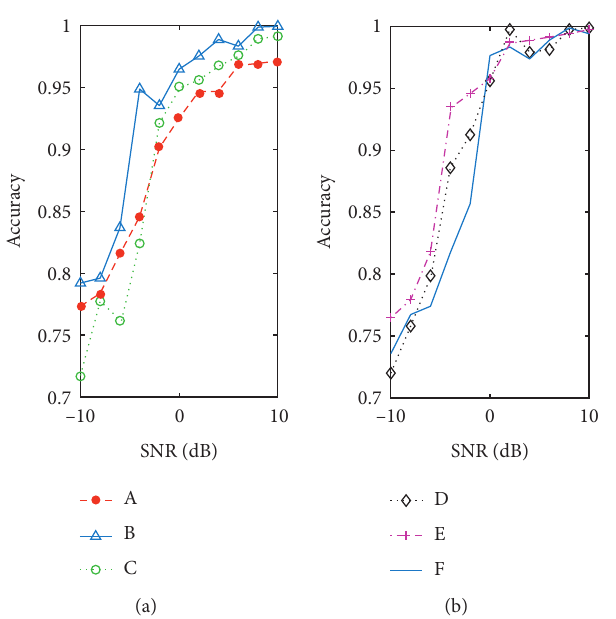
Figure 11: Different configured networks’ recognition accuracy: (a) different parallel structures; (b) different LSTM